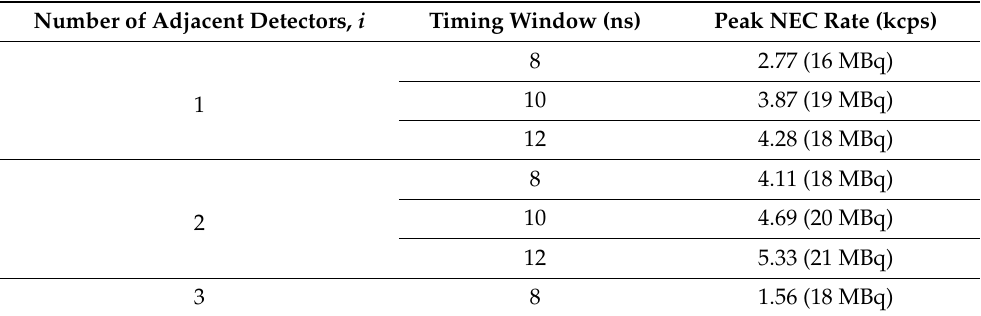
Table 1. NECR for varying coincidence pair number and timing window